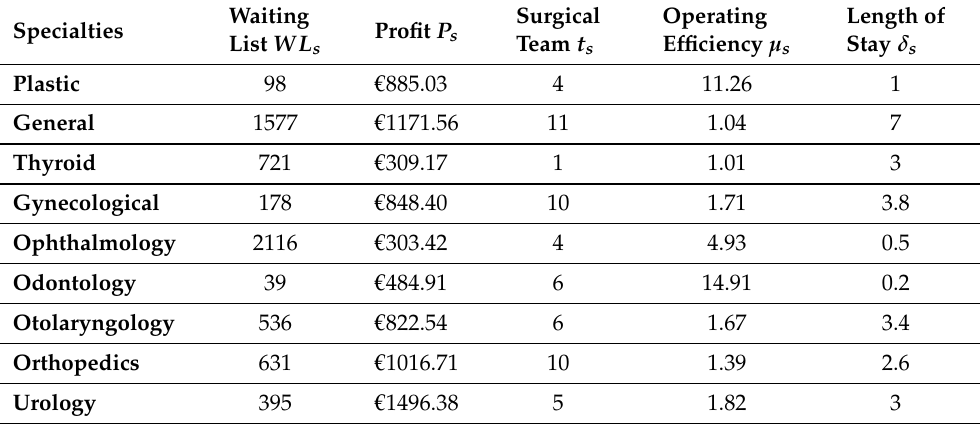
Table 1. Specialties Data